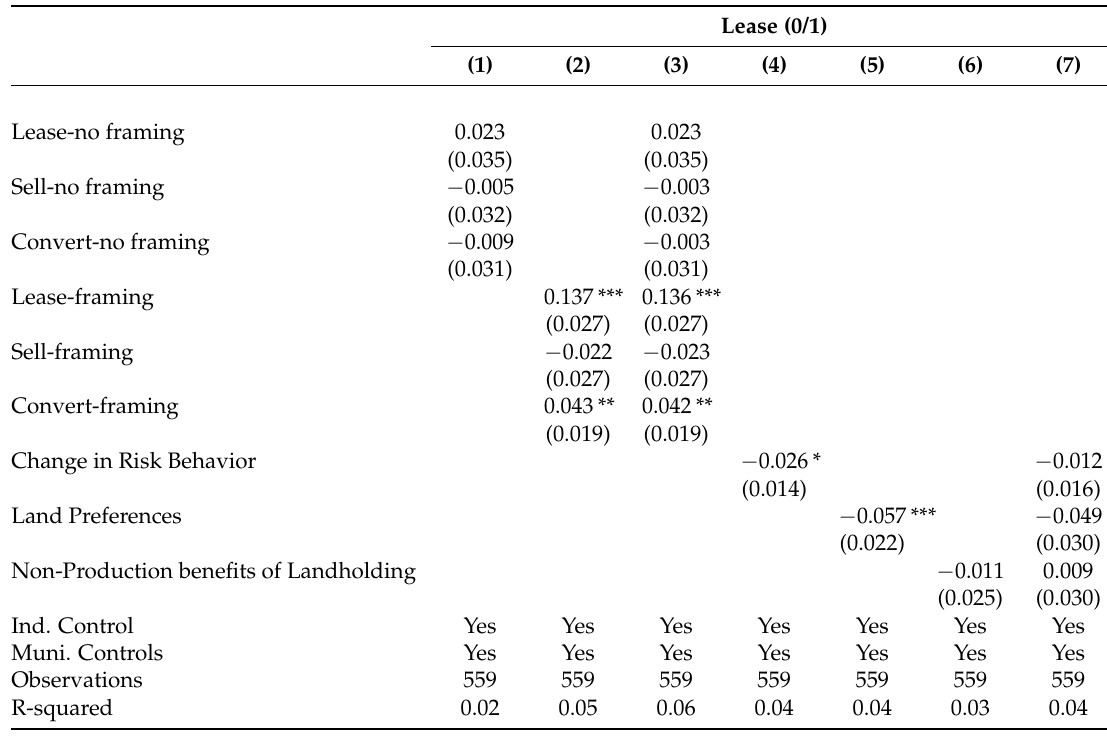
Table 11. Predictors of pasture conversion by